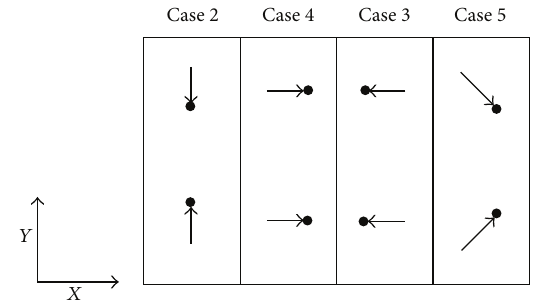
Figure 7: Different jet configurations of VGJ in the yaw ( x - y ) plane for pitch angle of 45 ∘